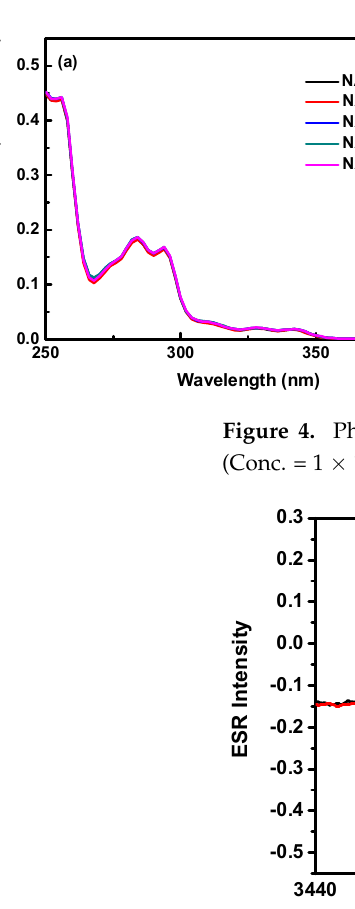
Figure 5. Experimental ESR spectra of the radicals generated by NA-2 or NA-3 irradiated with a UV lamp for 3 min and trapped by N- tert -Butyl- α -phenylnitrone (PBN) in t-butylbenzene solution.